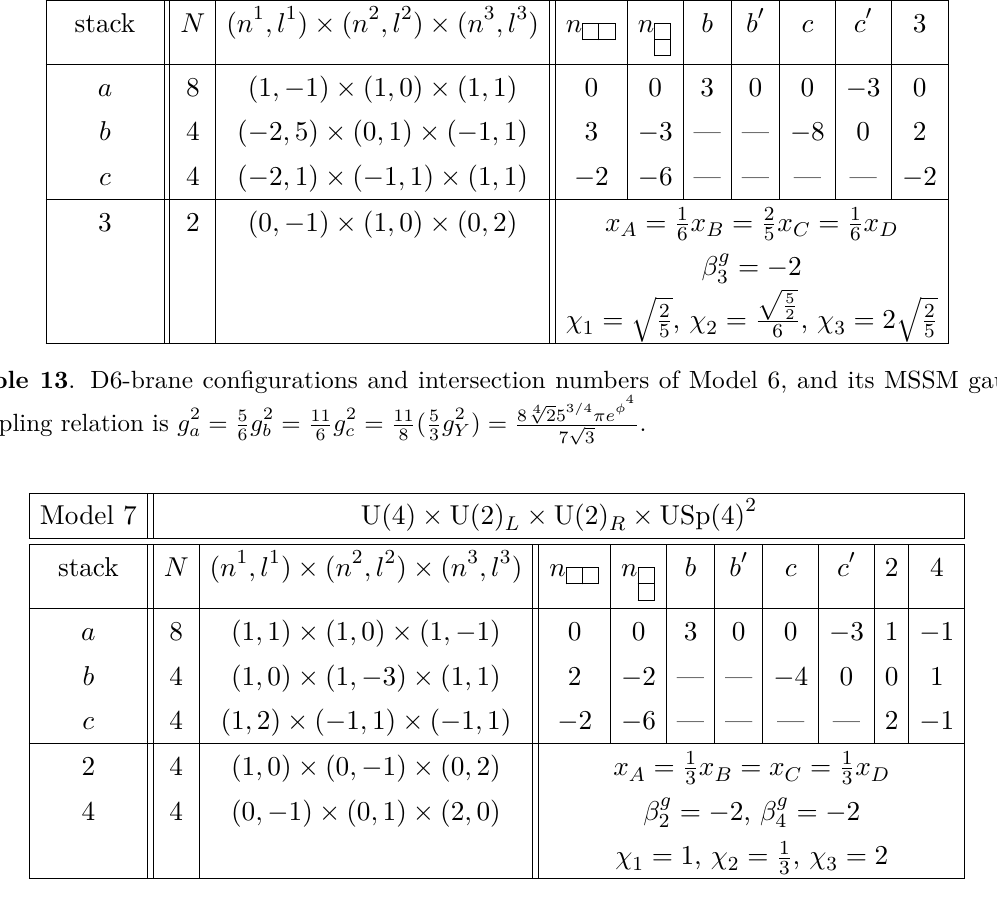
Table 14 . D6-brane configurations and intersection numbers of Model 7, and its MSSM gauge